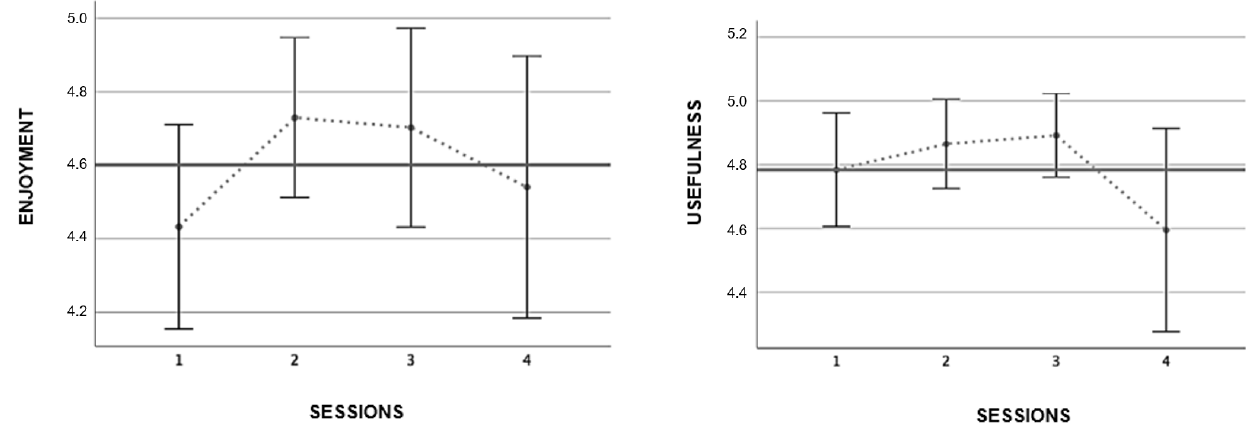
Figure 5. Enjoyment and usefulness of the cycling intervention. The bold line indicates the mean.